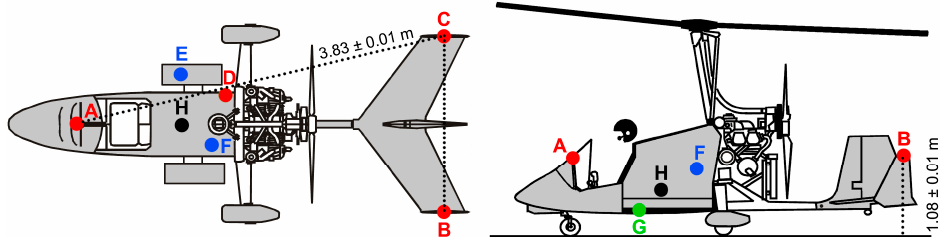
Figure 3. Scheme of the placement of the different devices on the Radgyro: (A) GNSS antenna (GPSA), (B) GNSS antenna (GPSB), (C) GNSS antenna (GPSC), (D) GNSS antenna connected to IMU (GPSIMU), (E) pressure and temperature sensors of IMU (PTIMU), (F) pressure and temperature sensors (PT), (G) radar altimeter (ALT), (H) gamma spectrometer NaI(Tl). GPSA, GPSB and GPSC are placed at the following relative distances: dGPSAB = dGPSAC = (3.83 ± 0.01) m and dGPSBC = (1.96 ± 0.01) m.